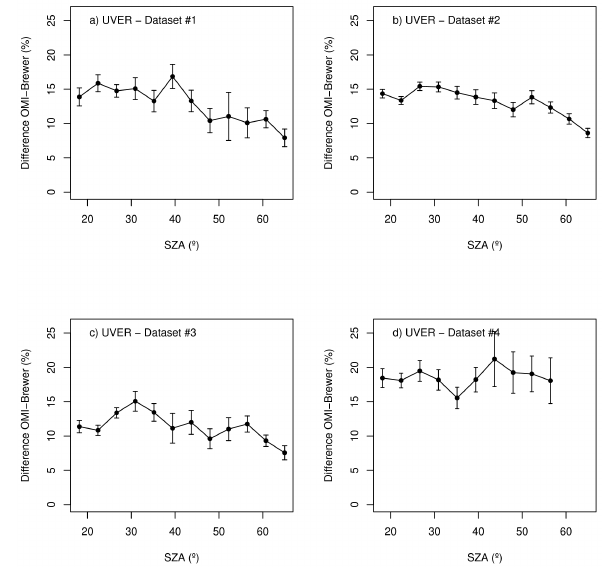
Fig. 5. The same as Fig. 4 but taking binned data for (a) all sky Figure 5 conditions (dataset #1); (b) for cloud-free sky condition or dataset #2; (c) dataset #3 and (d) dataset #4. The data are binned with 4.25 ◦